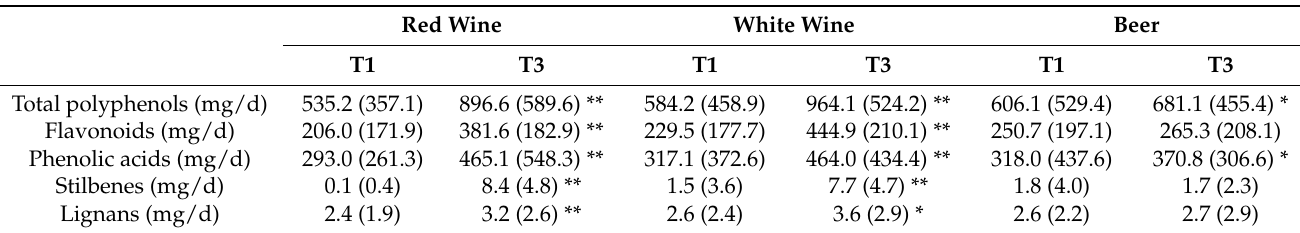
Table 4. Total and main classes of dietary polyphenols by consumption of alcoholic beverages containing polyphenols. Red